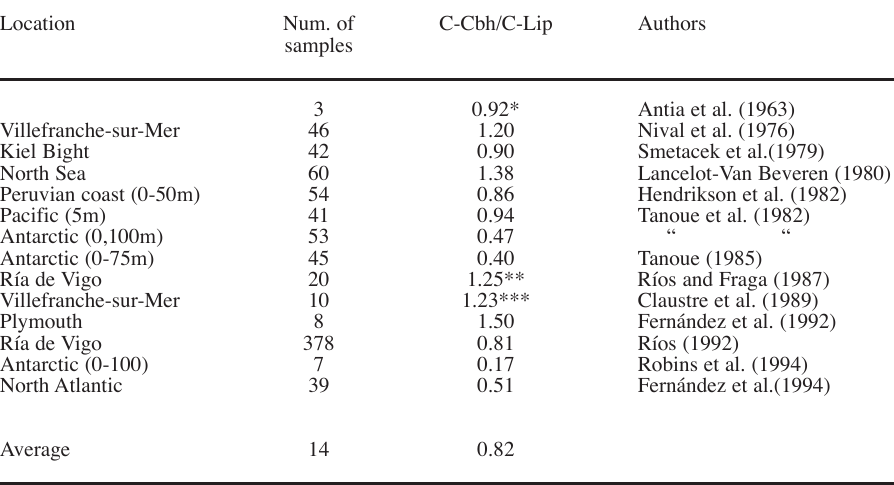
TABLE 3.- Σ Carbonydrate/ Σ Lipid ratio in carbon given by different authors. When the ratio was in weight we multiplied by 0.574 to transform it to carbon units.